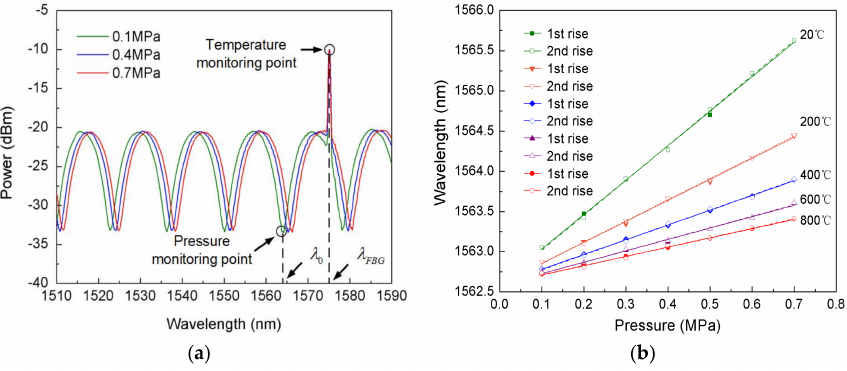
Figure 7. Interference spectrum: ( a ) FP interferometer with stable FBG; ( b ) The shifts of wavelength with pressure at 20, 200, 400, 600 and 800 ◦ C.